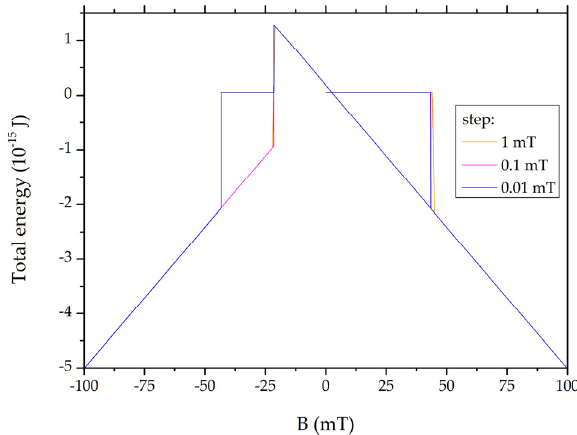
Figure 2. Total energy of different stable and metastable configurations of the chain at the distance d = 10 nm. The minima found by the software MuMax3 are slightly dependent on the field step Δ B, which has also been shown for three selected values.